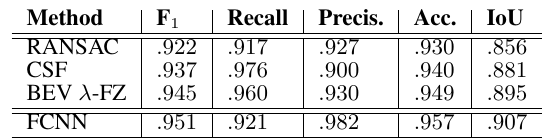
Figure 7. 3D ground detection results. Red points (TP), blue points (TN) and white points are false negative points. Table 1. Quantitative results obtained on sequence 08 of SemanticKITTI dataset for the ground detection task.